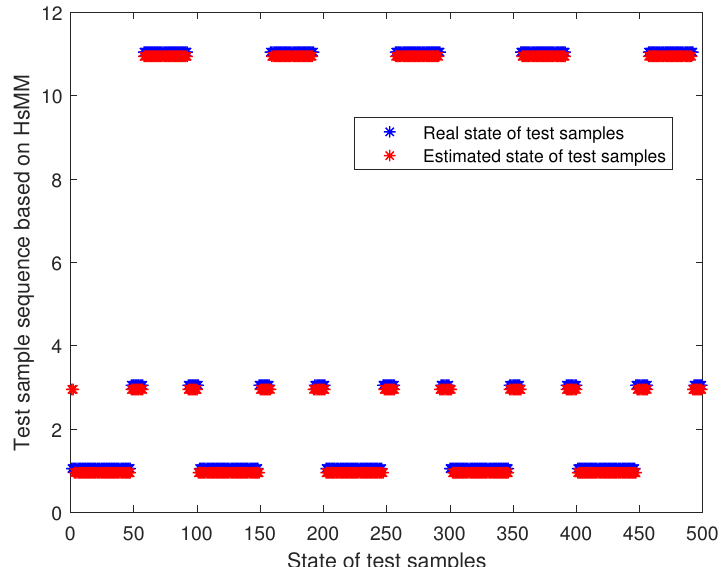
Figure 3. Comparison diagram of real state and estimated state of test samples based on HSMM when parameter D =